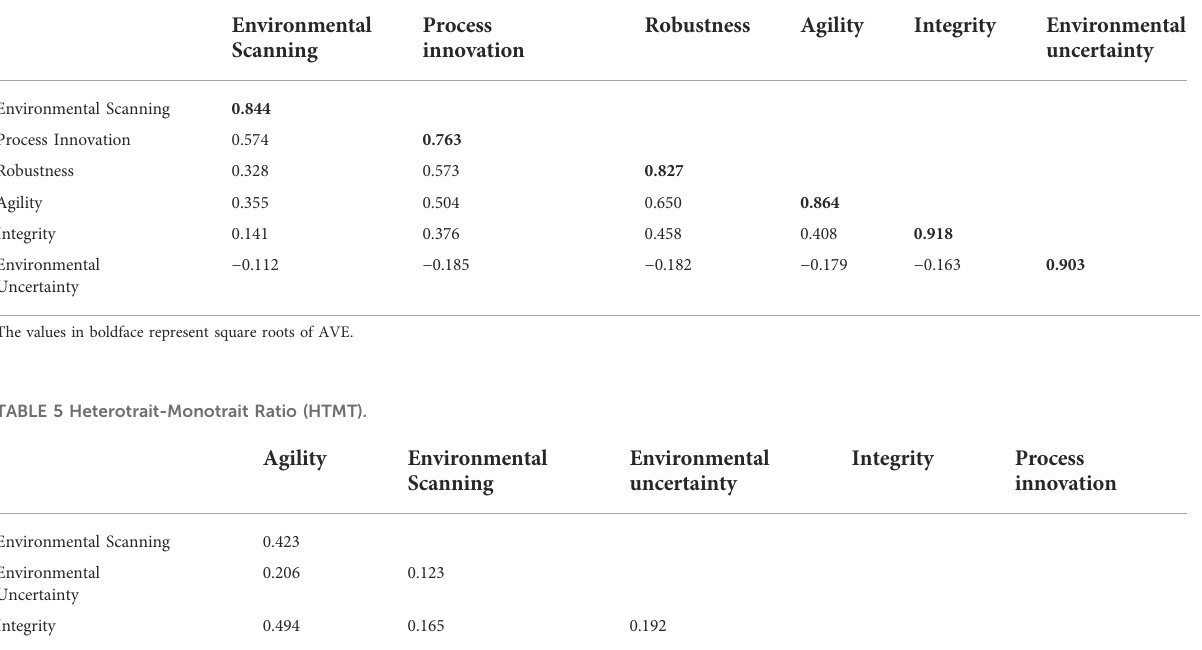
TABLE 4 Fornell-Larcker Criterion (Correlation between constructs and the square root of AVE).